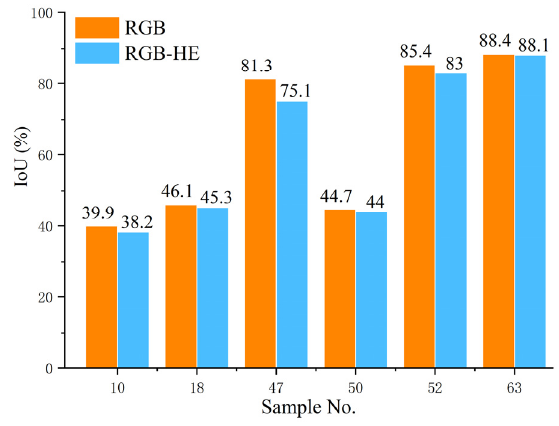
Figure 8. Samples with droped IoU after HE enhancement.